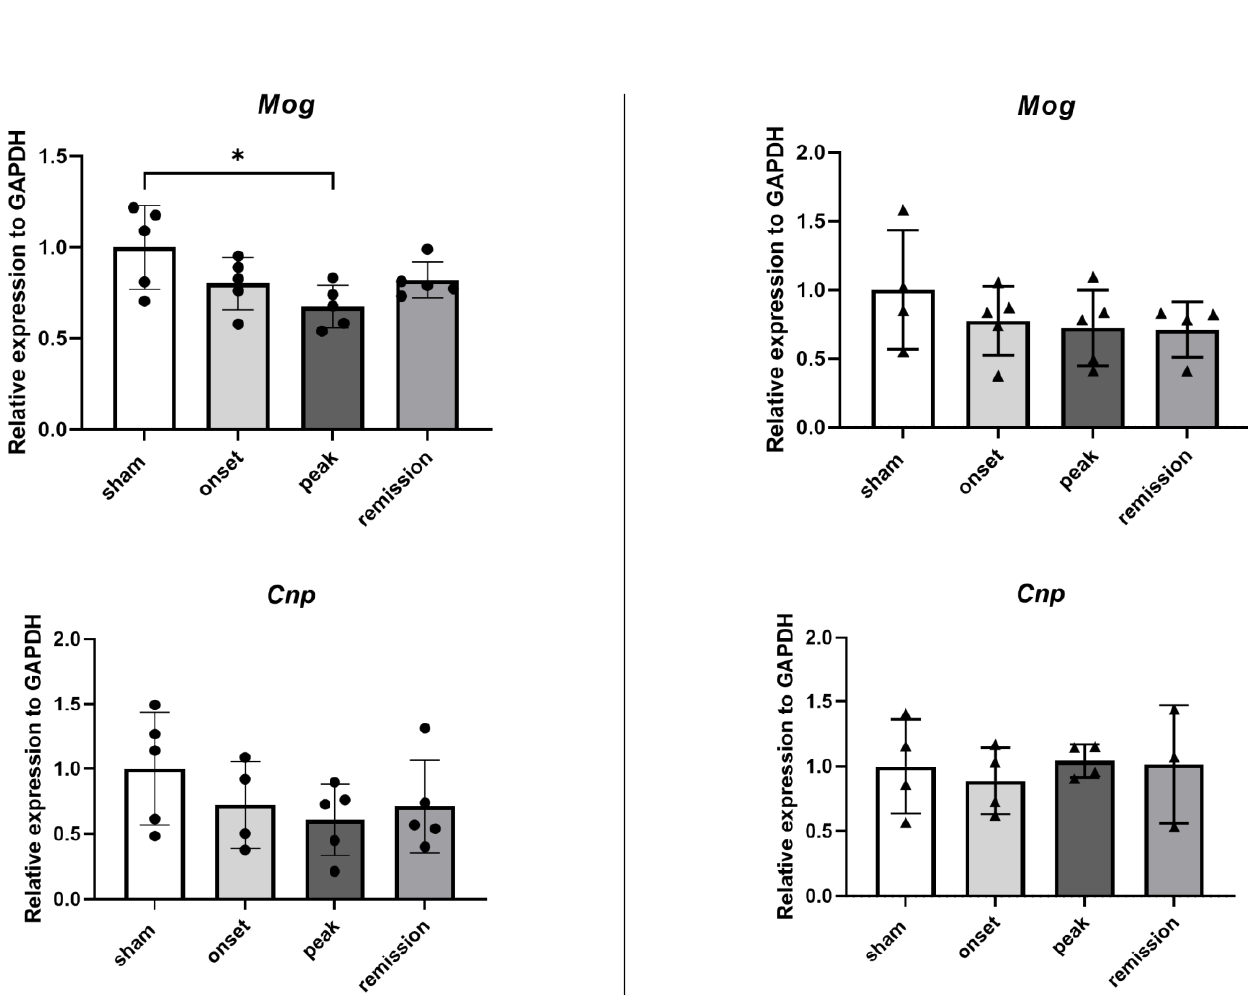
Figure 4. Differential expression of genes representative of oligodendrocyte damage in CNS organs during the different phases of PLP-induced EAE. The levels of mRNA transcripts for the selected genes relative to Gapdh were measured in the spinal cord ( left ) and brain ( right ) samples isolated from adjuvant controls and EAE mice on the onset, peak, and remission phases by RT-qPCR. A number of 3 to 5 mice was used in the experiment. Each symbol represents a sample. * p < 0.05 one-way ANOVA.